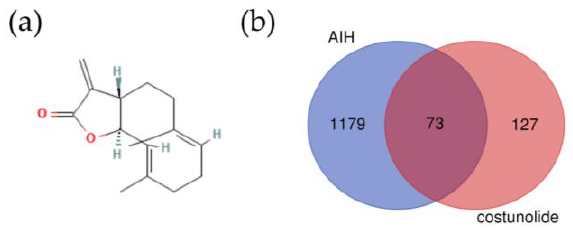
Table 1. Pharmacological and molecular properties of costunolide.